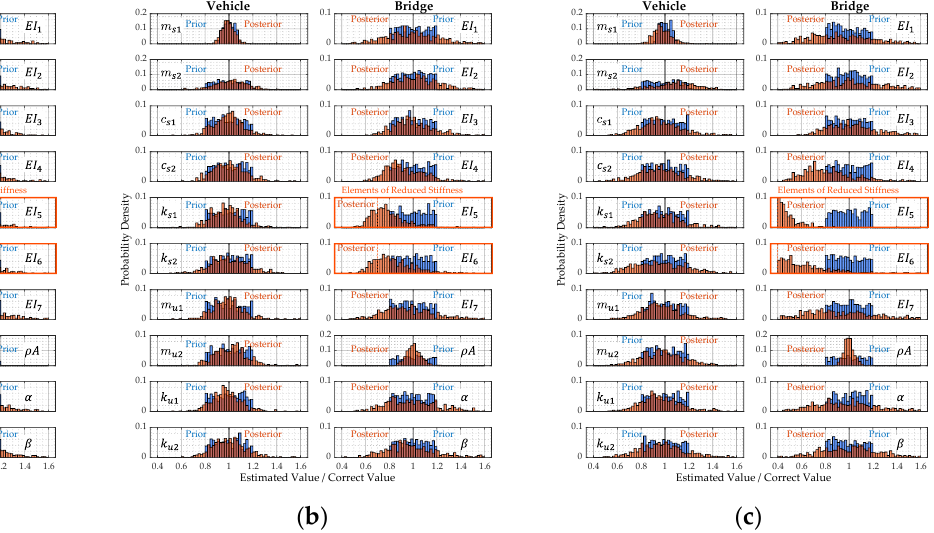
Figure 16 shows the probability density distributions of all estimated mechanical pa- rameters in (a) Scenario 10, (b) Scenario, 11 and (c) Scenario 12, respectively. These cases indicate edge stiffness reduction. According to these figures, the tendency of stiffness re- duction cannot be detected from the estimated distributions of 𝐸𝐼 7 . However, the next elements have underestimated values. This underestimation can help detect stiffness re- duction at the bridge’s edge.